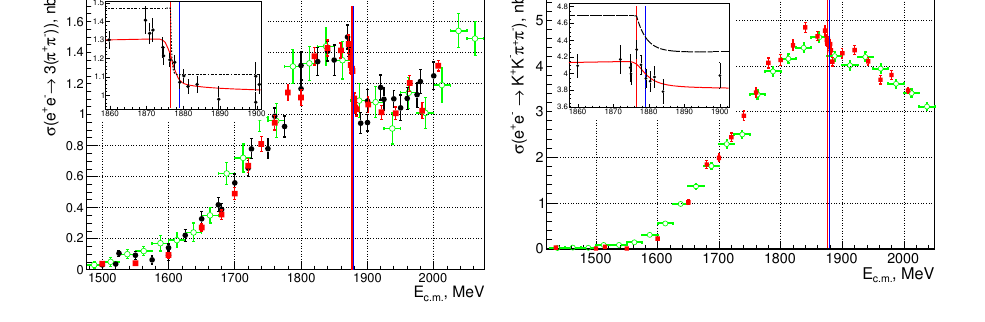
Figure 2. The e + e − → 3( π + π − ) Born cross sec- tion measured with the CMD-3 detector in the 2017 run (squares). The results of the previous CMD-3 measurement [8] are shown by dots and those of BaBar [6] by open circles. The inset shows the visible cross section with the fit de- scribed in the text. The vertical lines show the N ¯ N thresholds.